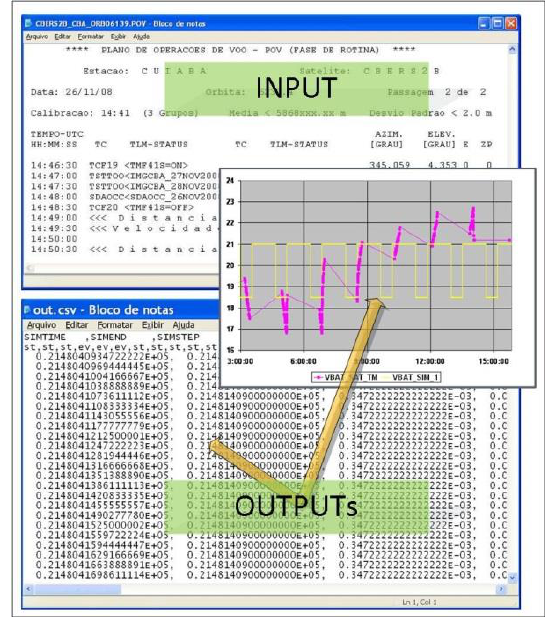
Fig. 4. Files and tables artifacts as CBERS simulation input/outputs.